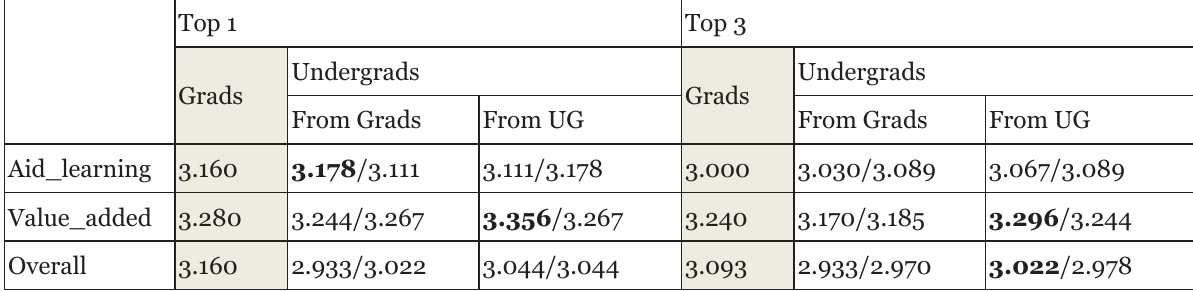
Average Ratings from PopCon2D: Popularity Only Top 1 Grads